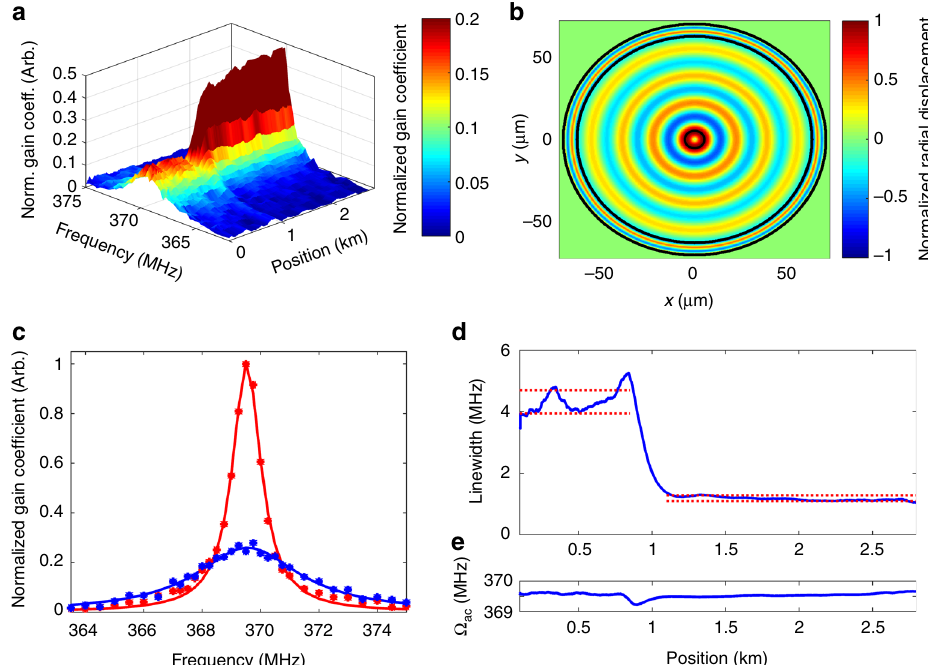
Fig. 6 Optomechanical time-domain re fl ectometry of a polyimide-coated fi bre. a Optomechanical time-domain re fl ectometry map of the nonlinear coef fi cient γ ( Ω , z ) as a function of frequency detuning Ω /(2 π ) between two co-propagating optical fi elds and position z along a fi bre under test. The R γ Ω ; z ð Þ d Ω is the same for all positions z . The standard single-mode fi bre under test is coated with polyimide nonlinear coef fi cients are normalized so that with outer diameter of 140 µ m. The fi rst 850m of the fi bre were immersed in water, and the rest was kept in air. Optomechanical coupling with a resonance frequency of 369.5MHz due to mode R 0,11 of the coated fi bre is observed throughout its length. The coupling spectrum in air is narrower with a stronger peak. b Calculated normalized transverse pro fi le of the material displacement of the radial mode R 0,11 that is guided by the silica-polyimide structure, as a function of Cartesian coordinates x and y . c Spectra of optomechanical coupling in fi bre sections 750m from input end (blue, in water), and 2.5km from the input end (red, in air). Markers present measurement data, and lines show fi tted Lorentzian line-shapes. d Linewidths Γ 11 ( z )/(2 π ) as a function of position. The ranges of experimental uncertainty in the linewidth measurements, for fi bre in water and air, are noted by horizontal dotted lines. The uncertainties are estimated by the standard deviation of the measured linewidths in each segment. e Resonance frequencies Ω 11 ( z )/(2 π ) as a function of position